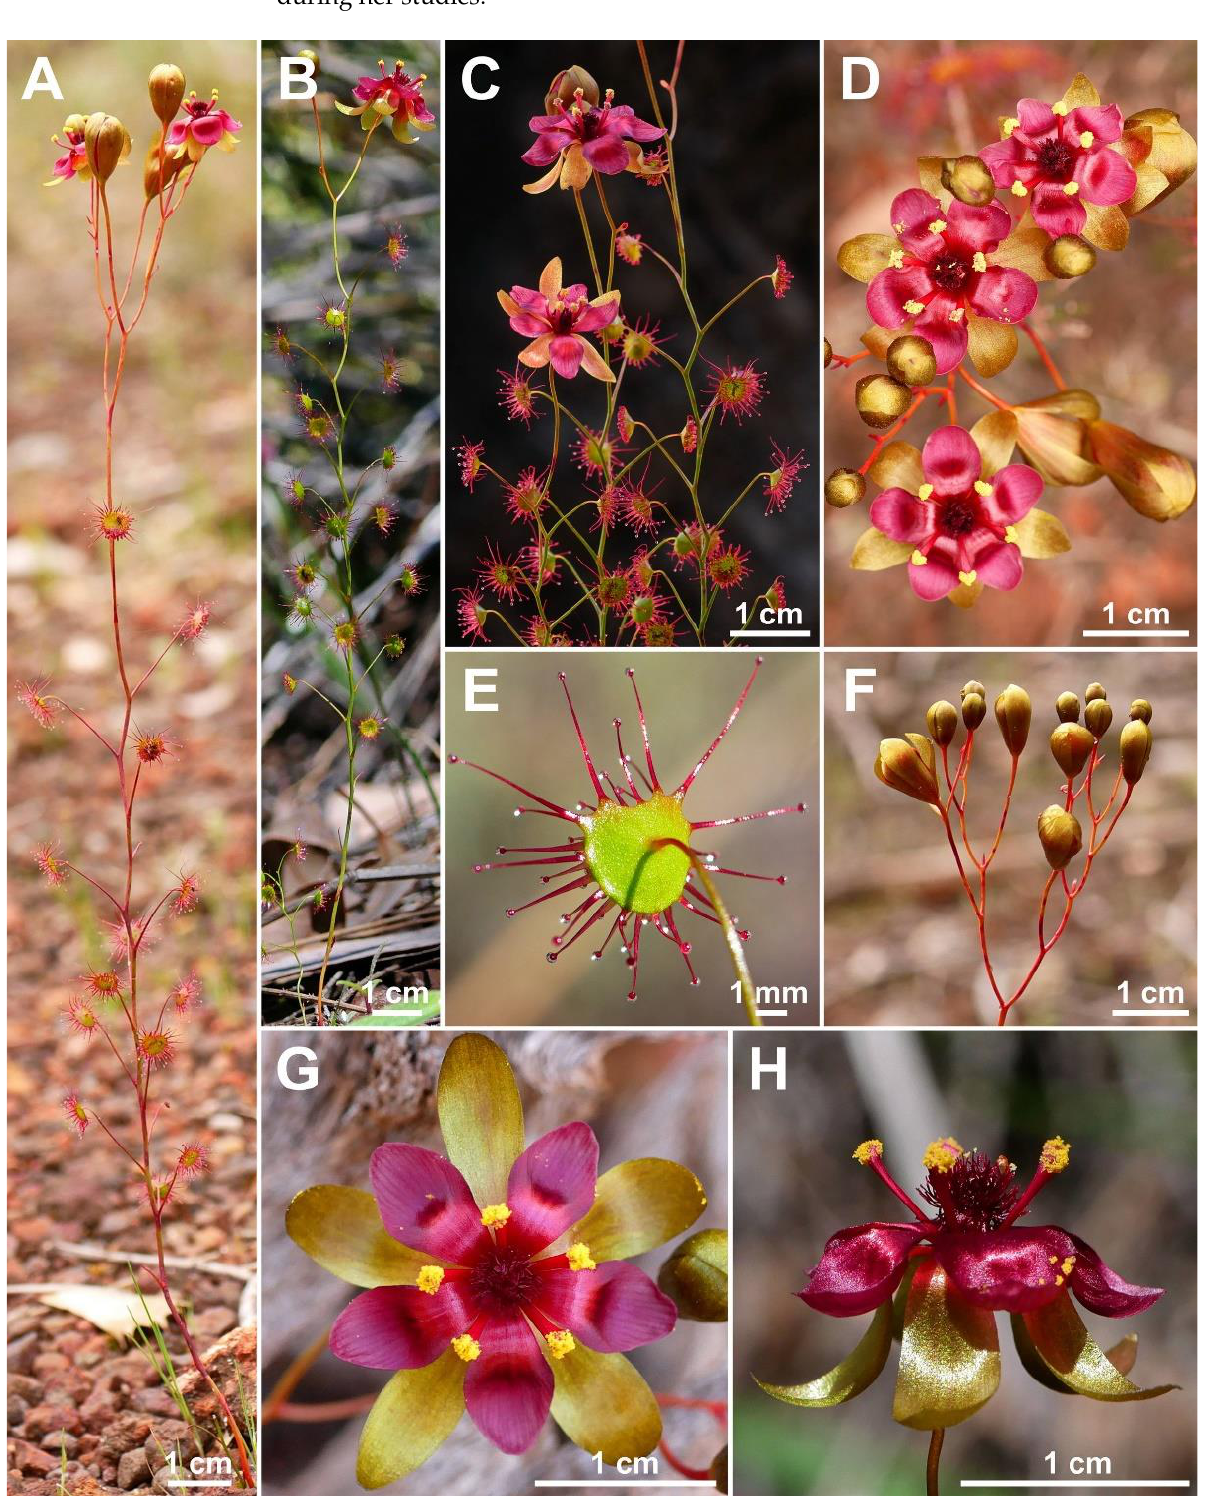
Figure 6. Drosera calycina Planch. ( A – C ) habit; ( D ) flowers in diffuse light; ( E ) lamina, abaxial view; ( F ) branched inflorescence; ( G ) flower in diffuse light; ( H ) flower in bright sunlight, lateral view. ( A – D , F – H ) from John Forrest National Park, Western Australia, 8 September 2022; ( E ) from Roleystone, Western Australia, 11 July 2021. Images: T. Krueger.